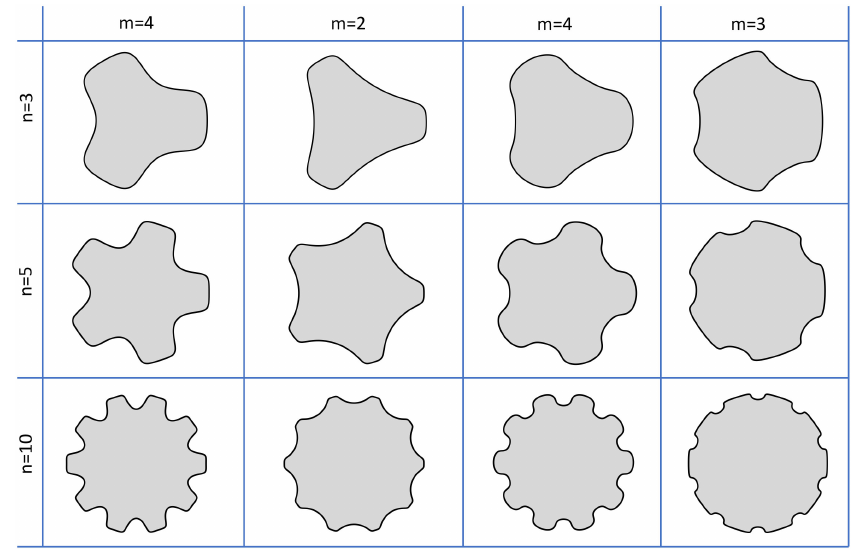
Figure 2. Examples of the complex hybrid trochoid (M-profiles) with additional eccentricities, where m represents the order and n represents the periodicity of the profile.